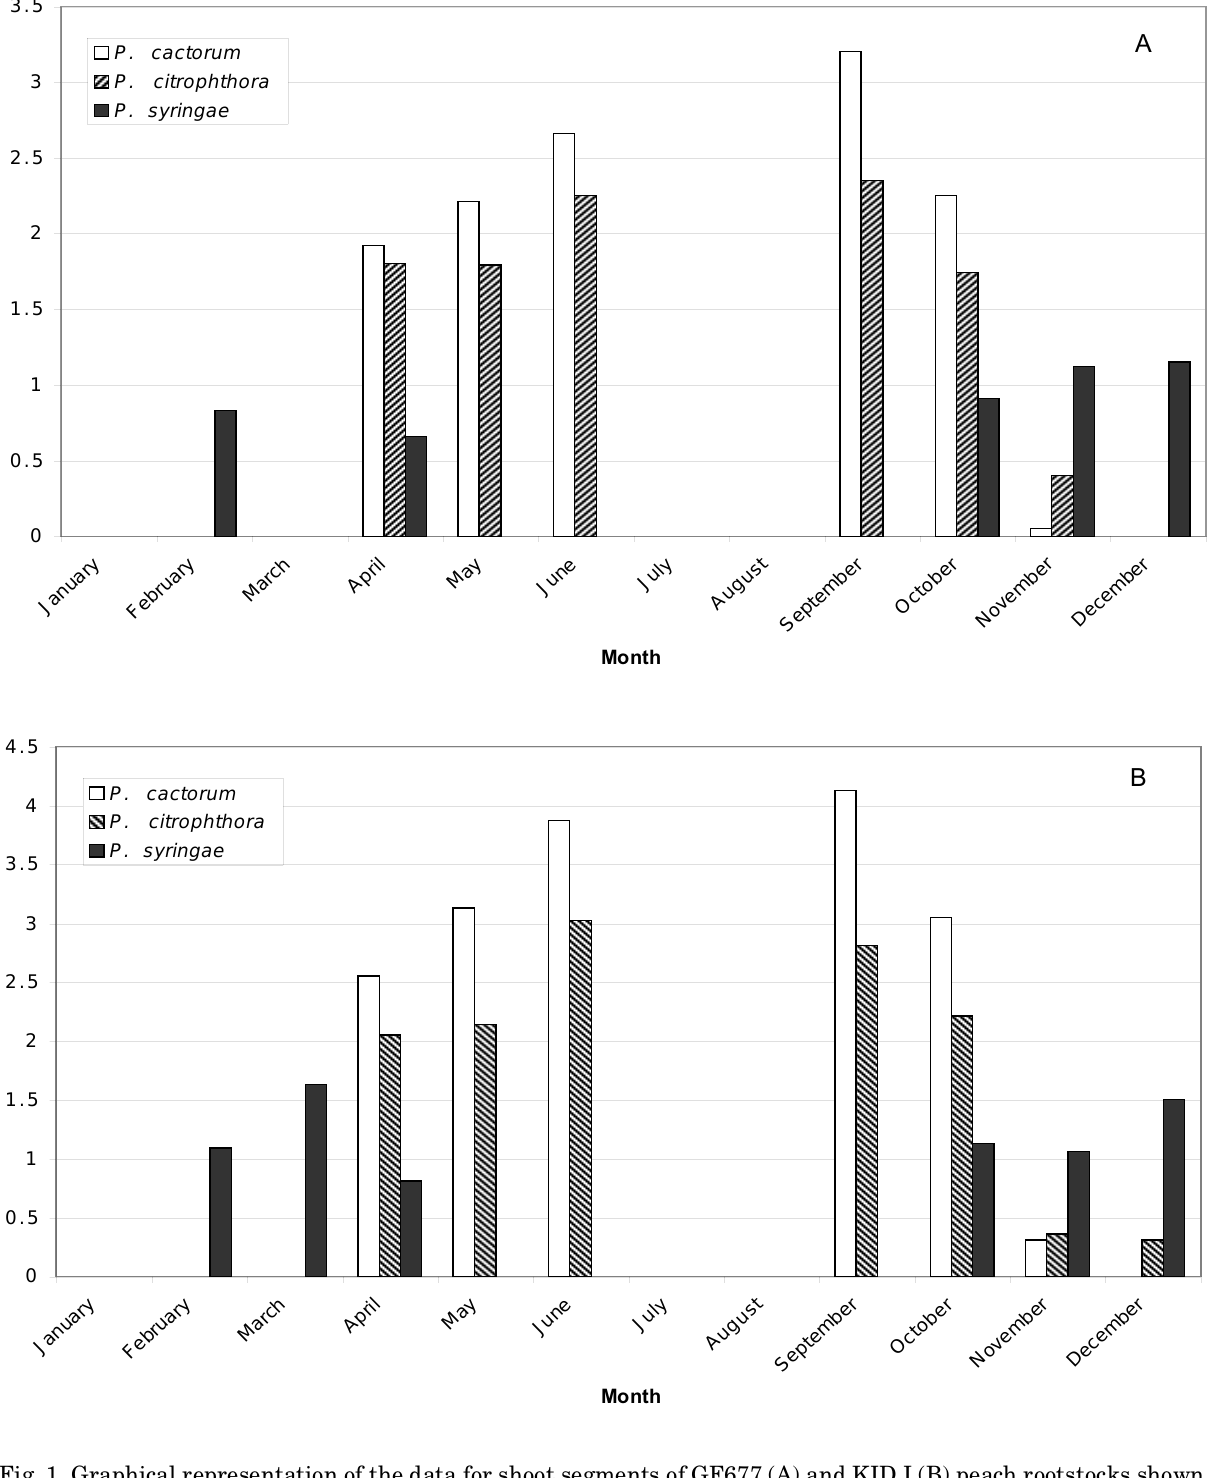
Fig. 1 Graphical representation of the data for shoot segments of GF677 (A) and KID I (B) peach rootstocks shown in Table